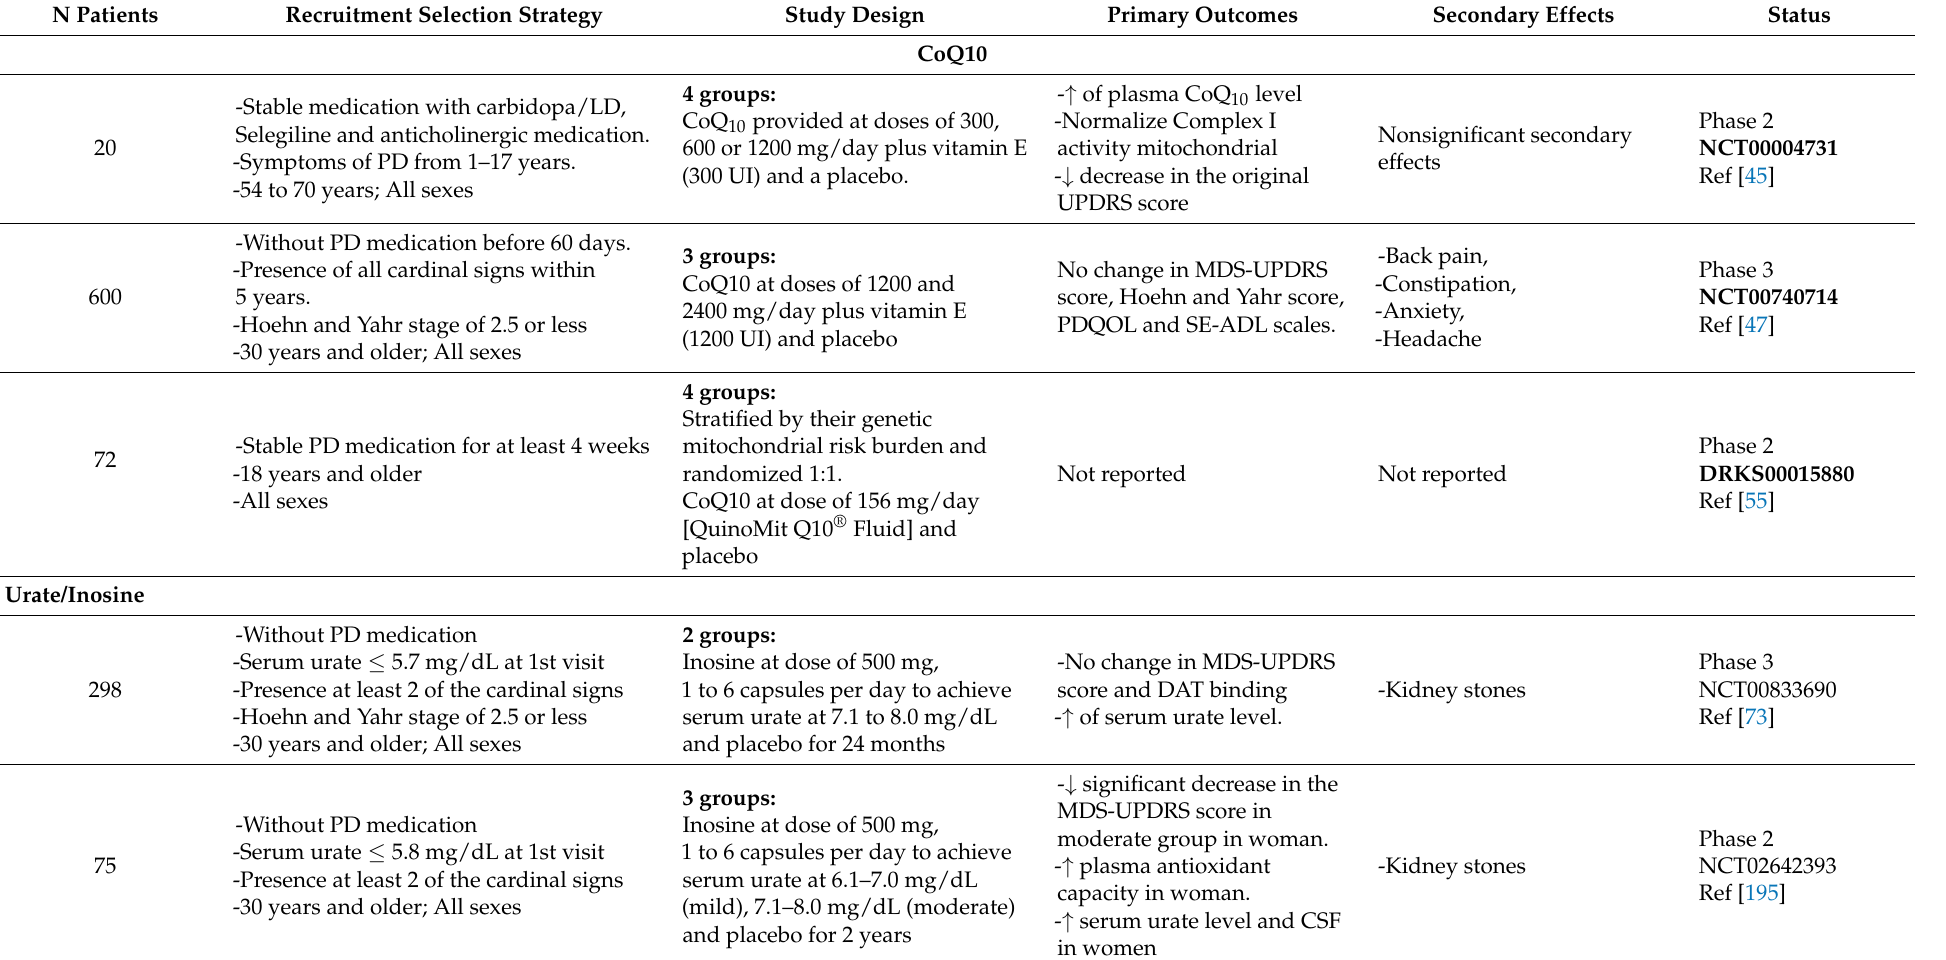
Table 1. Summary of recent clinical trials that are published or currently underway (https://clinicaltrials.gov, accessed on 3 June 2022). N